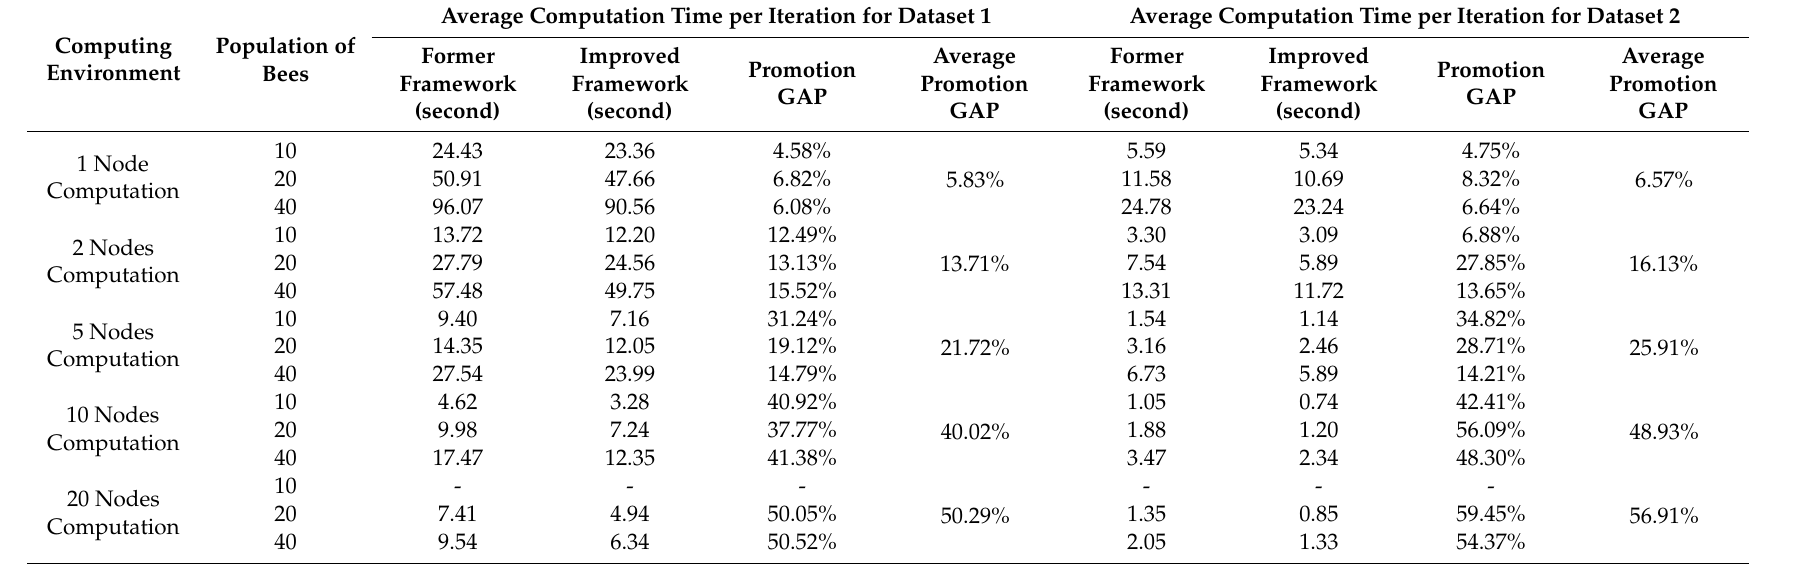
Table 8. E ffi ciency Statistics of the Improved MA-based ABC Framework and the Framework Proposed in [17] for